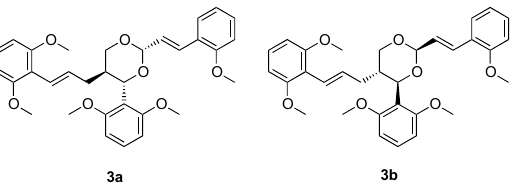
Figure 10. Chemical structures of the chiral (±)-torreyunlignans [58].